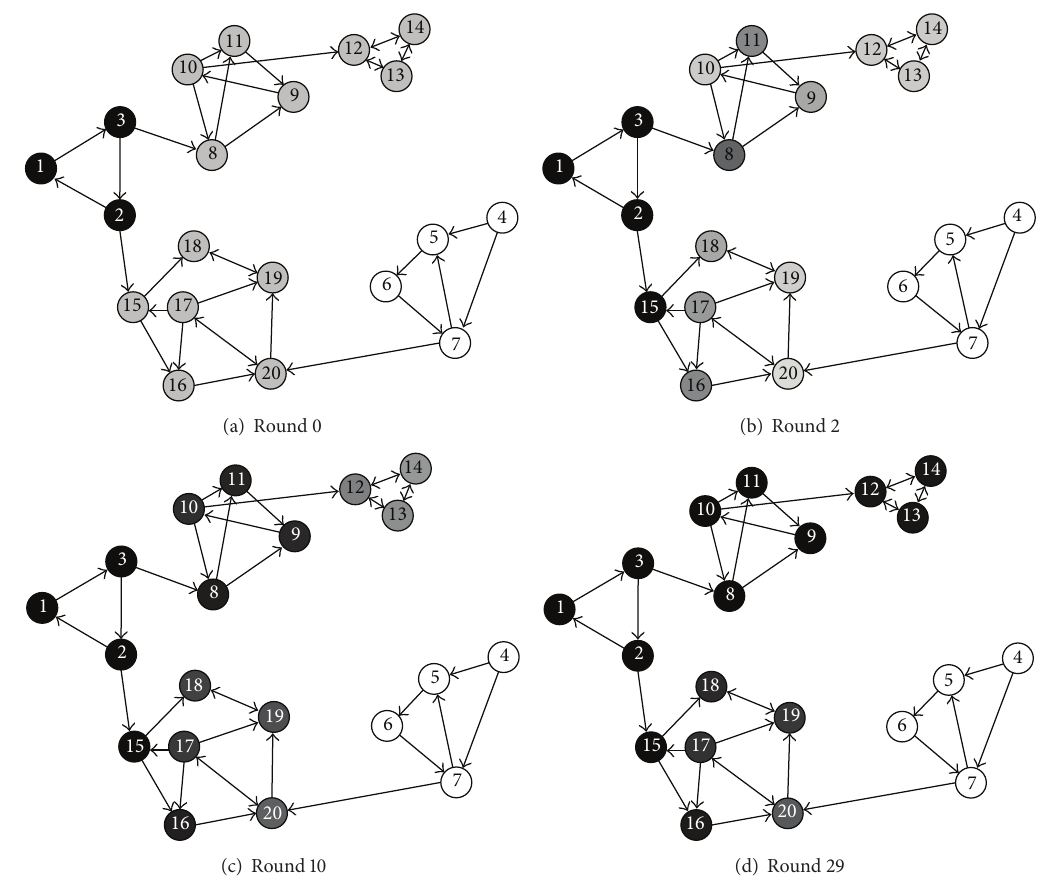
Figure 2: Time evolution of preferences held by nodes in a social network, demonstrating the effects of opinion leaders creating their own consensus and passing it down to opinion followers in a cascading